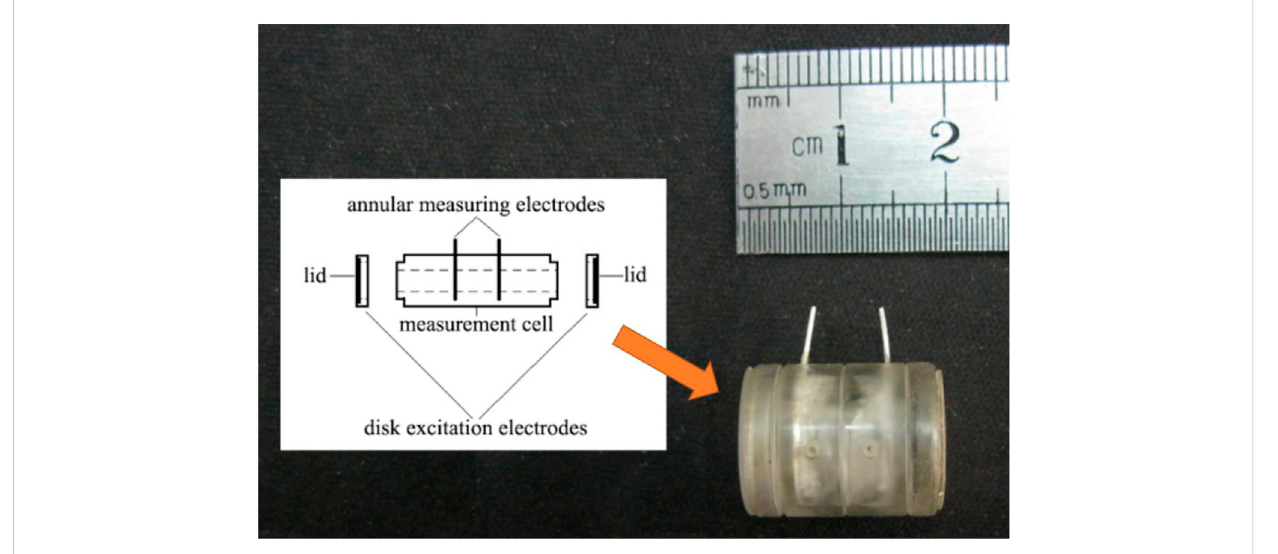
FIGURE 1 Measurement cell with four